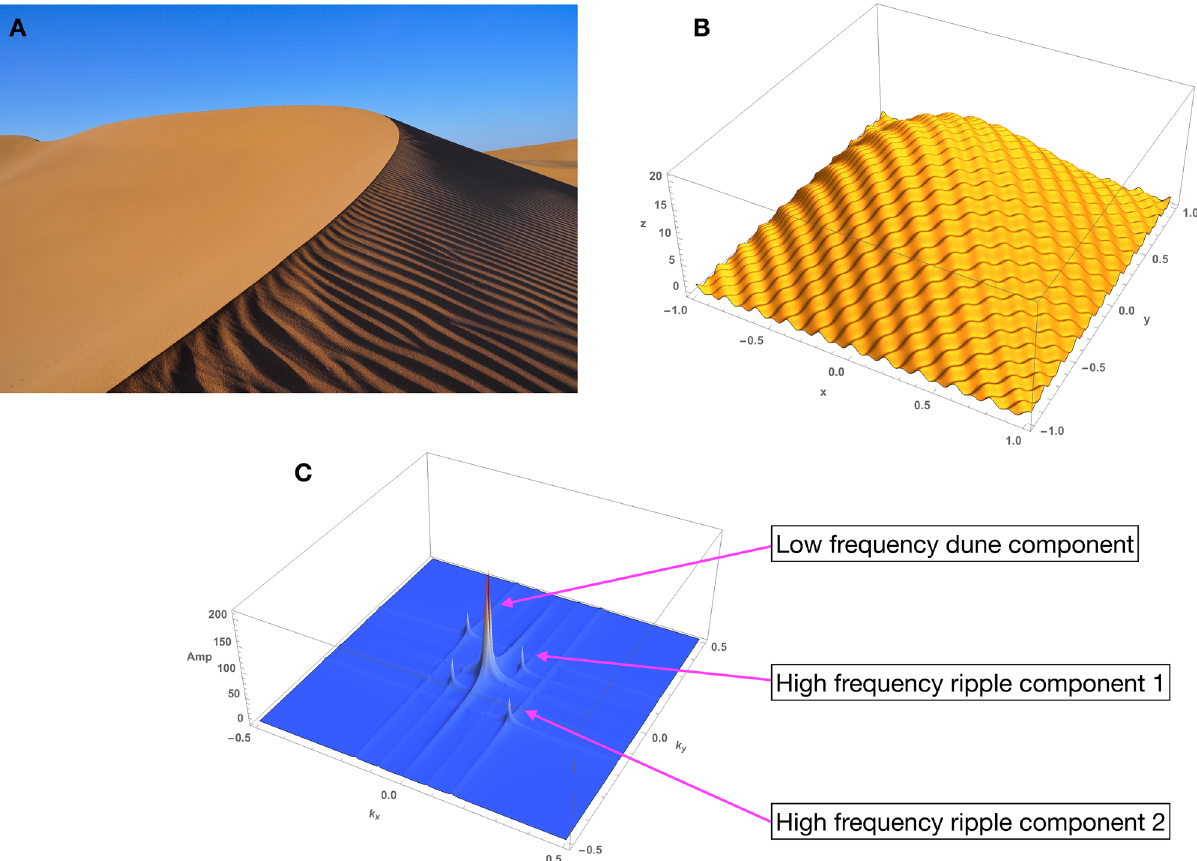
Figure 8. Shape characterization with Fourier plane waves. ( A ) Real sand dune, with surface ripples. ( B ) Numerically generated (idealized) sand dune with ripples. The underlying dune is represented by a single low spatial frequency, high amplitude wave. The ripples were generated by the sum of two high frequency, 45 low amplitude waves oriented at 45 ◦ and ◦ relative to the y -axis. The entire dune is the sum of all these − waves. ( C ) The magnitude of the Fourier Transform (FT) of ( B ) detects these three waves. The location of the peaks gives the spatial frequency, the angle of the peaks in the ( k x , k y ) plane provides the angle in the spatial ( x , y ) domain. These estimated Fourier components characterize the dune shape. The mirror image peaks are redundant information that result from the symmetry of the FT. The small ridges emanating from the peaks are a consequence of the finite nature of the numerical